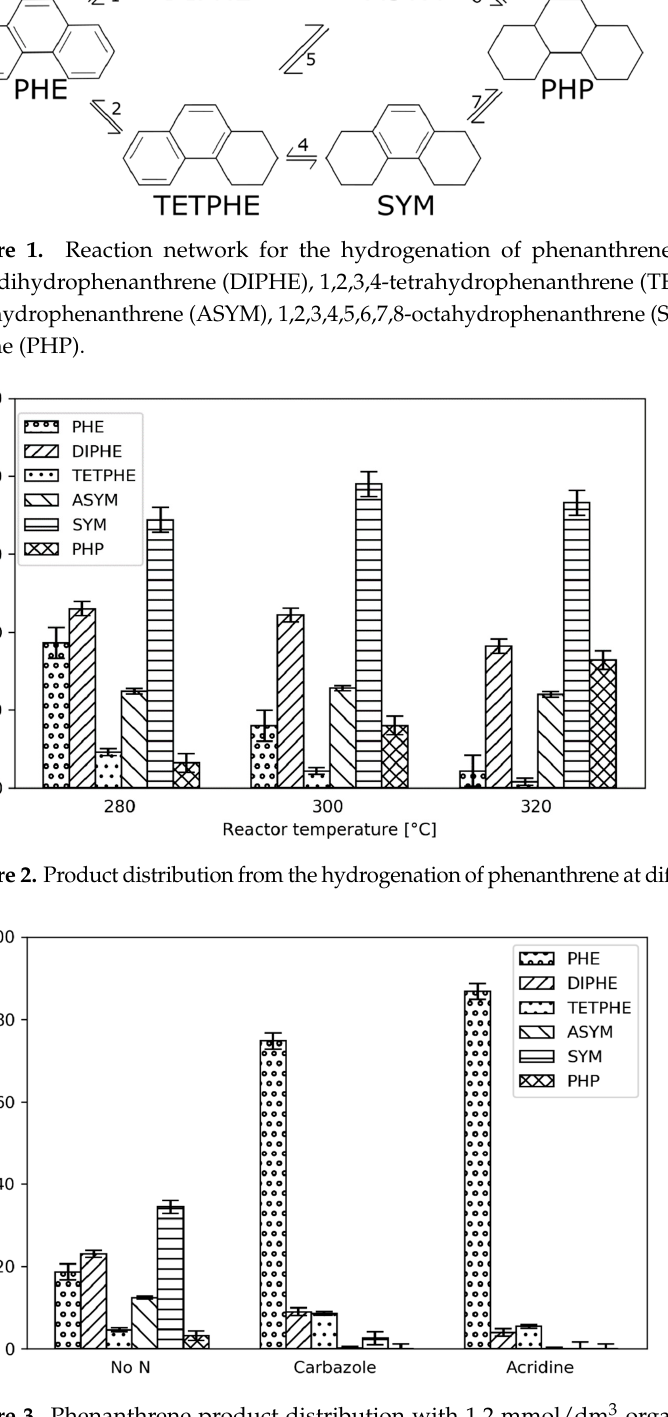
Figure 4. Phenanthrene product distribution with 1.2 mmol/dm 3 organic nitrogen (carbazole or ac- ridine) present in the reactant feed at a reactor temperature of 300 °C.